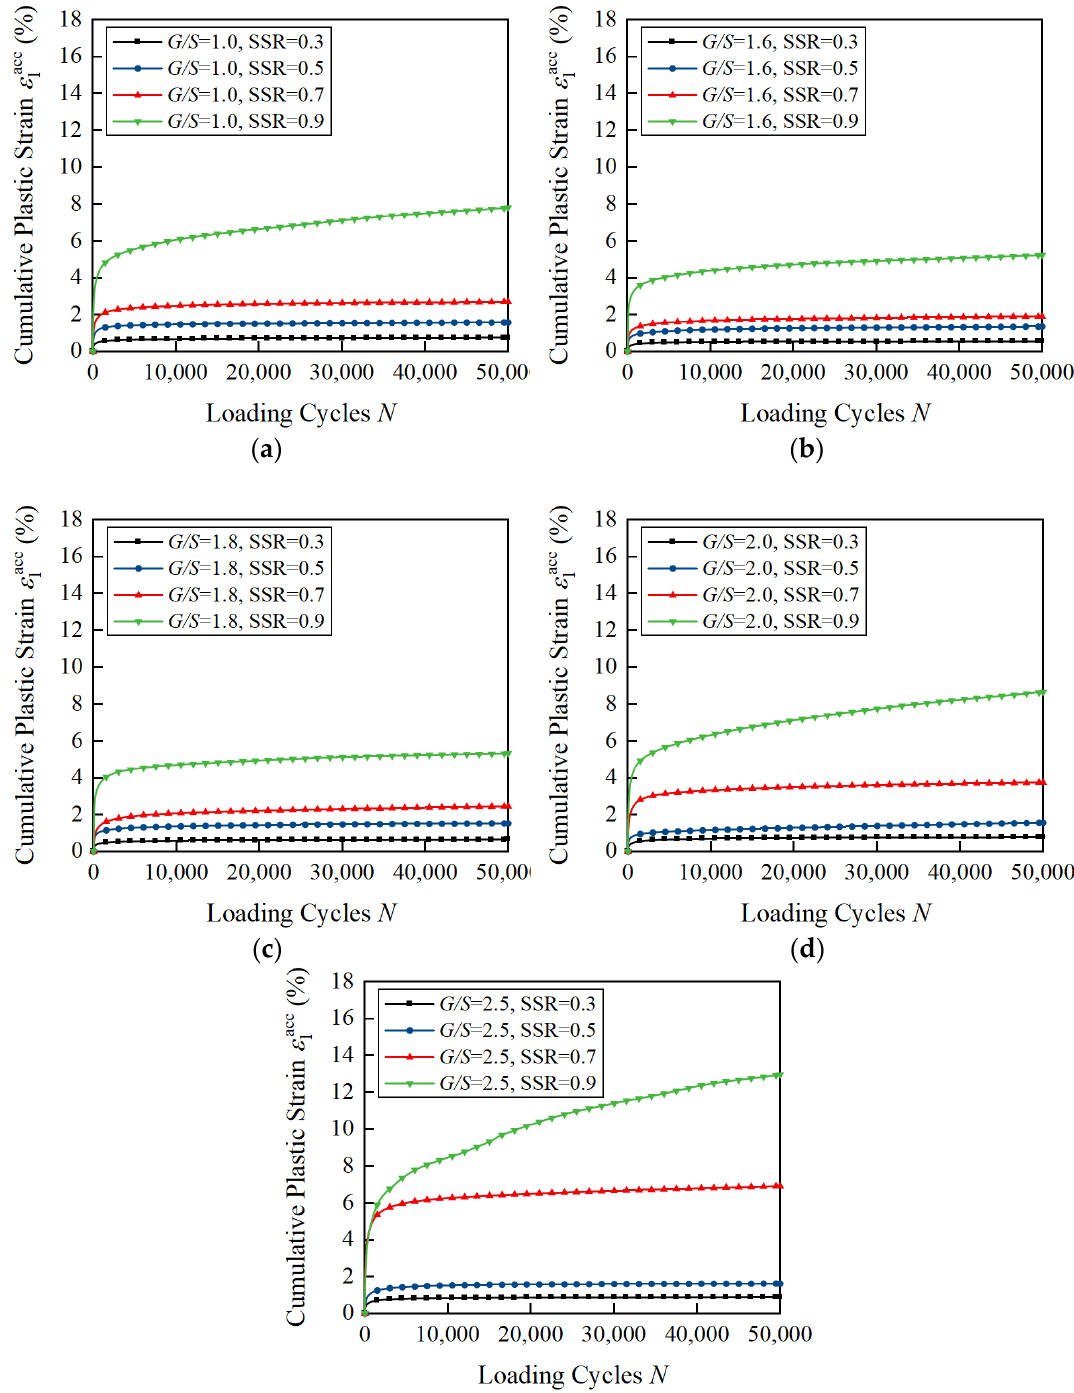
Figure 7. Laboratory-measured permanent deformation of unbound aggregate base materials with different G / S values under confining pressure of 150 kPa and different SSR levels: ( a ) G / S = 1.0; ( b ) G / S = 1.6; ( c ) G / S = 1.8; ( d ) G / S = 2.0; ( e ) G / S = 2.5.